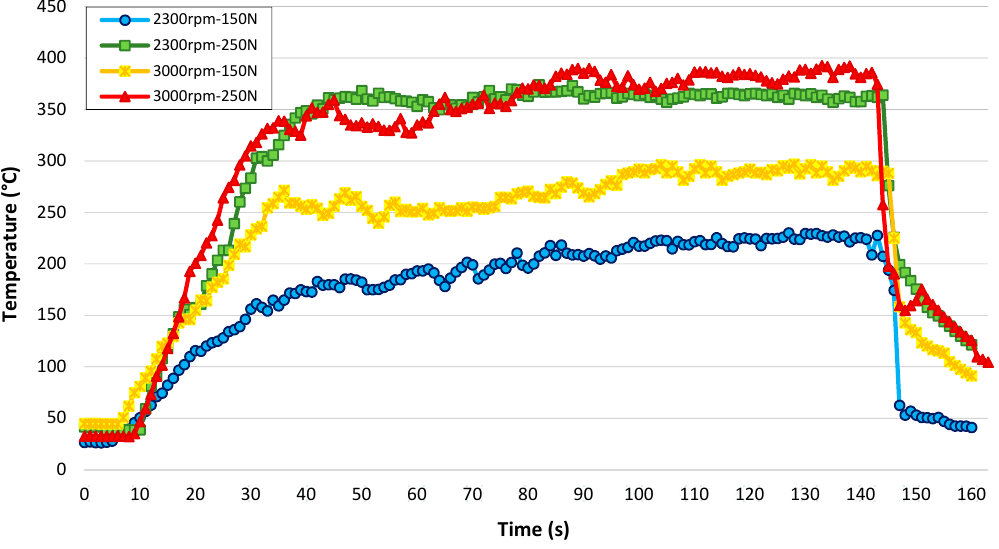
Figure 6. The maximum temperature during the friction surfacing process.